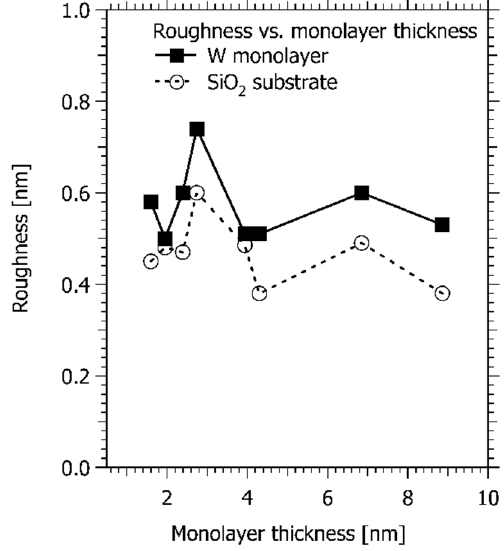
Figure 4. Roughness vs. thickness for W monolayers.